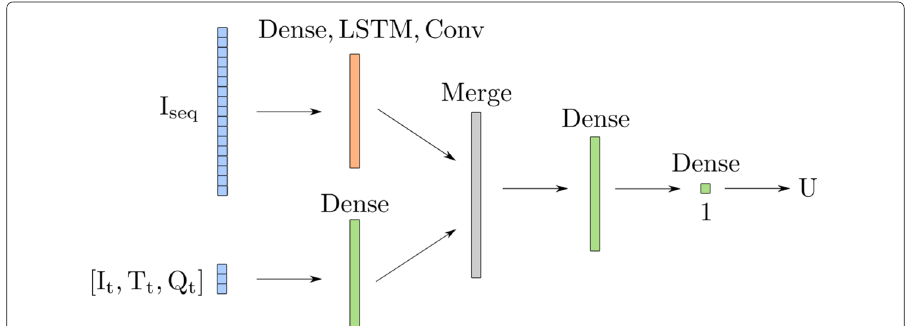
Fig.4 Illustration of the “Merge Neural Network” architectures. The architectures differ by the chosen network type in the top branch (orange). The MergeFFNN uses dense layers exclusively, whereas the MergeLSTM utilizes LSTM neurons. In terms of the MergeCNN architecture, multiple convolutional layers are